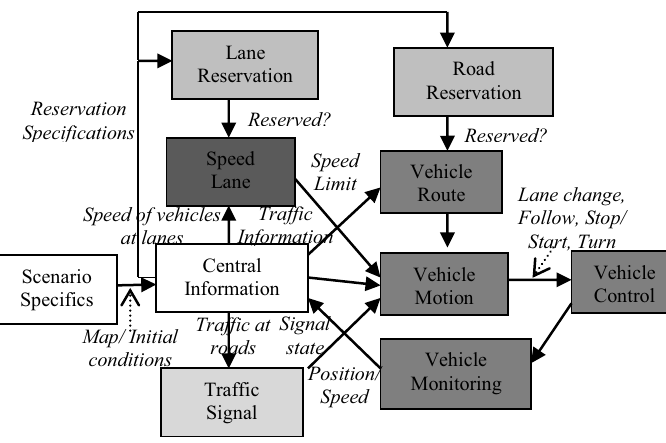
Fig. 9. Planning Architecture of the Simulator.